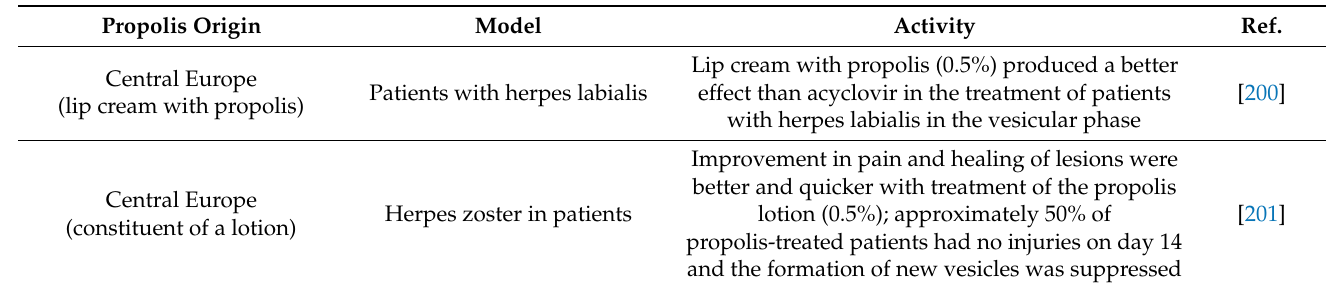
Table 19. Antiherpetic activity of Central European propolis in patient